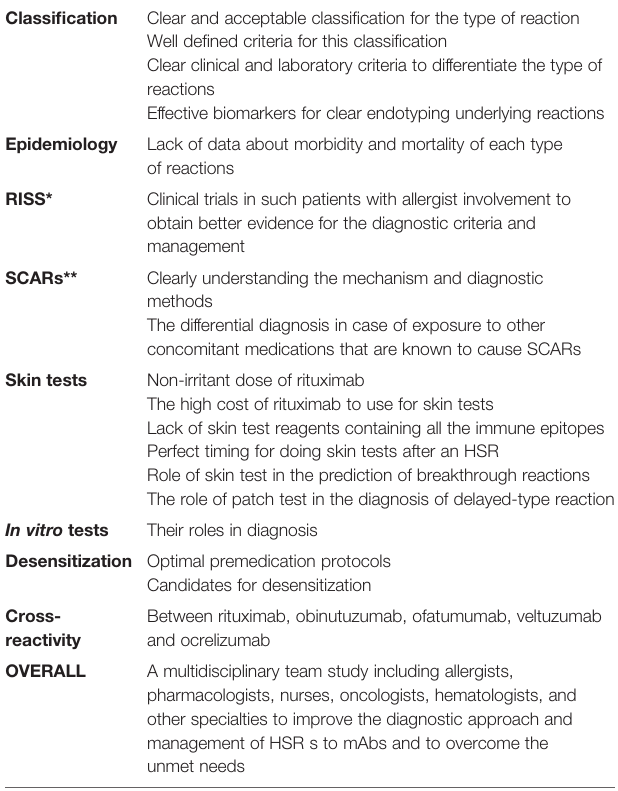
TABLE 4 | Unmet needs and future research for HSRs to